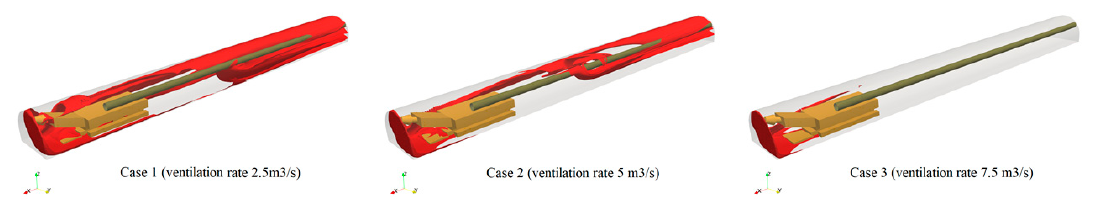
Figure 8. Radon distribution with concentrations ≥ 500 Bq/m 3 .